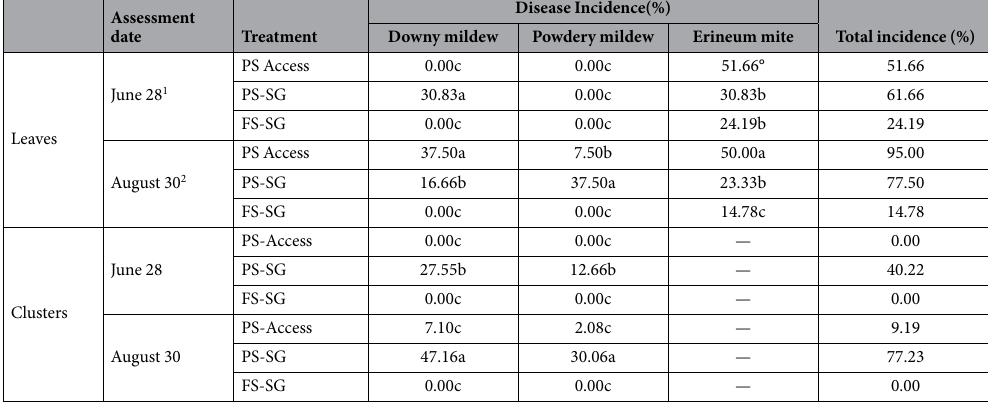
Table 1. Incidence (%) of downy mildew, powdery mildew and erineum mite evaluated during disease assessments on June, 28 1 and August 30 2 . Small letters obtained by Fisher protected Least Significant Difference (LSD). Test show significant differences for P < 0.05. PF = partially sprayed. FS = fully sprayed. 1 BBCH 77 berries beginning to touch; 2 BBCH 89 berries ripe for harvest; °Brix ≅ 18.